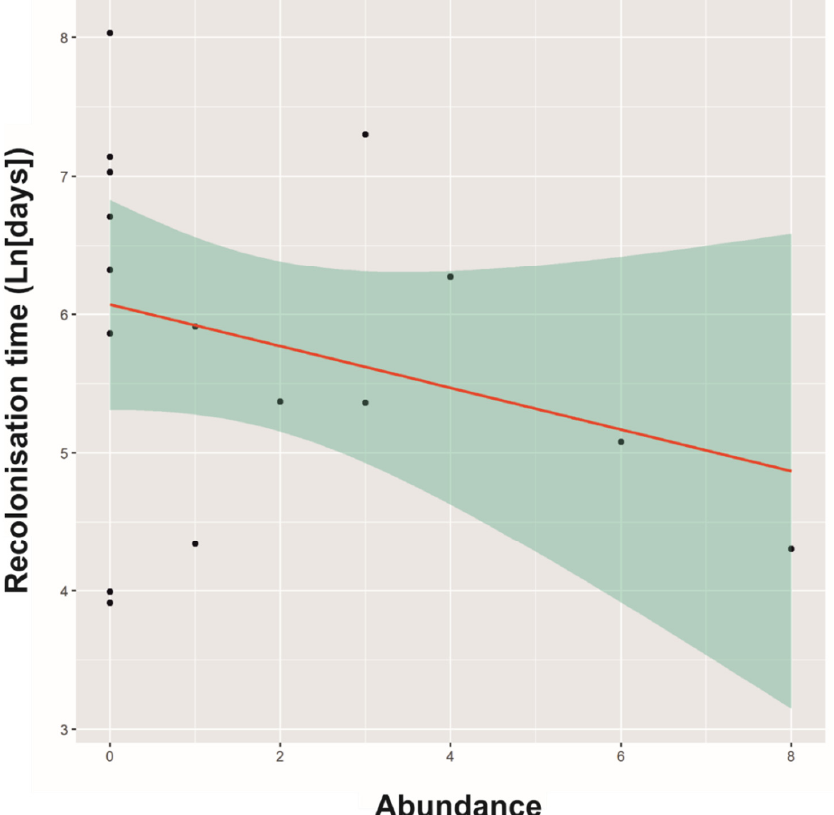
Figure 3. Relationship between the recolonisation time, expressed as Ln (days), and the abundance of Feral Pigeons remaining at the end of a control programme. A 95% credible interval is denoted by the shaded area.